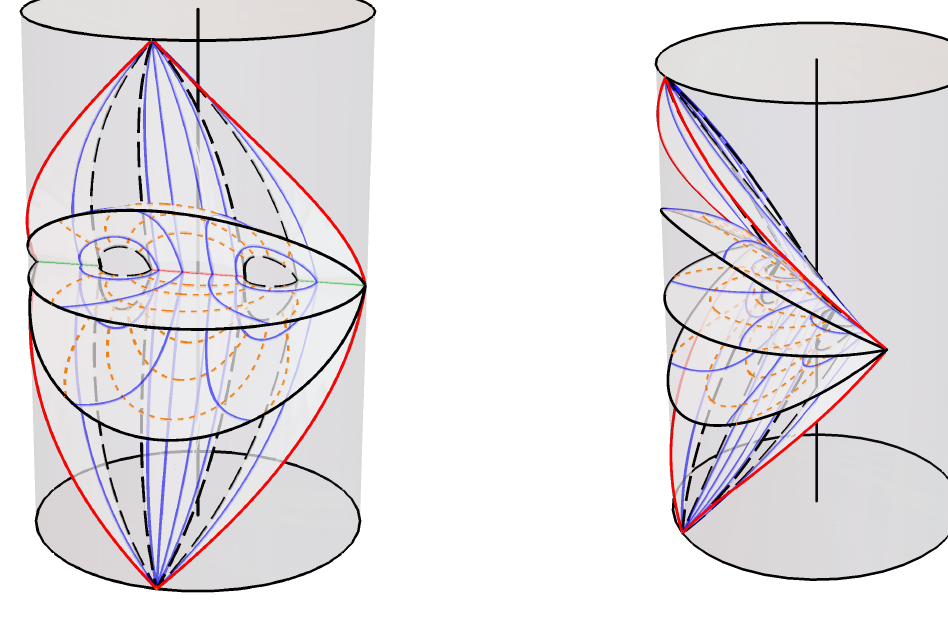
Figure 15 . The Class II right,rapid black hole. Several surfaces of constant t are shown. The lines x = x + < y h are shown in dashed black, and are identified with their partner within the same time slice. The early and late time-slices show the event horizons. The black hole event horizon has a compact bifurcation surface with topology S 1 , shown in red, while the green line denotes the “acceleration horizon” or droplet’s bifurcation line with topology R . Lines of constant y are shown in dashed orange. Lines of constant x are shown in blue. The classically accessible region of the boundary is delimited in